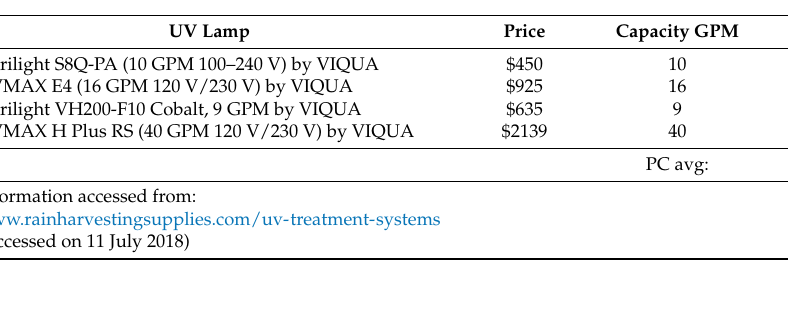
Table A9. Price per capacity scaling factor calculations for UV